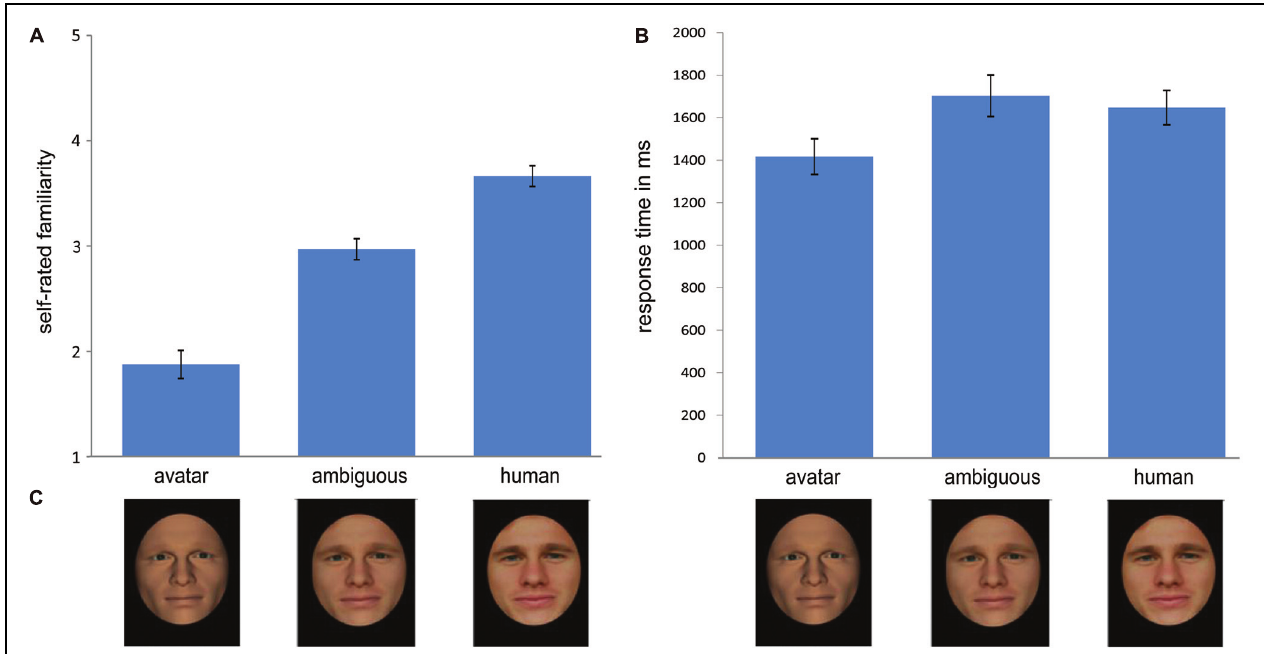
FIGURE 5 | Self-reported feelings of familiarity. (A) Illustrates a general increase in familiarity ratings with increasing human likeness from the avatar to the human faces (A) . Reflecting the pattern of response times for categorization response times in the two-alternative forced choice categorization task, response latencies for ambiguous faces are longer compared with the avatar